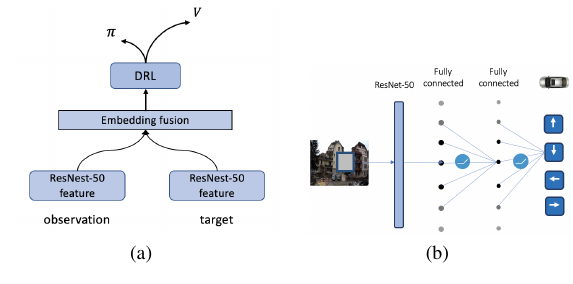
Figure 3. (a) The outline of the network architecture, the ResNet-50 are pre-trained on ImageNet. (b) Schematic illustration of the critic network. The ResNet-50 extracts feature from the original image.